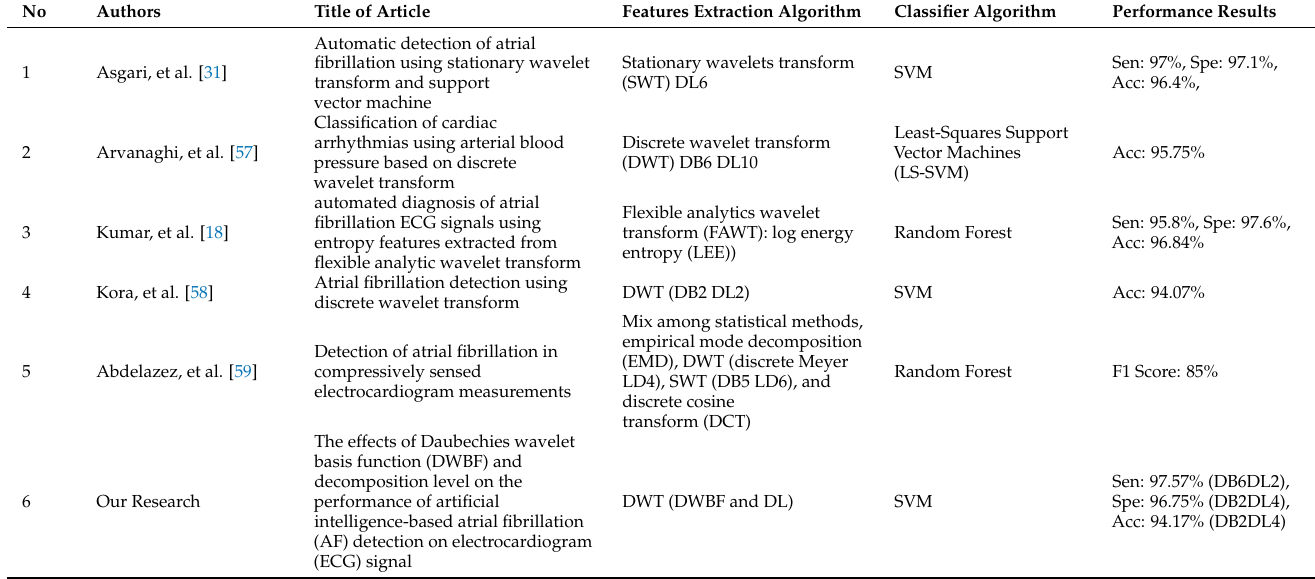
Table 8. Performance of atrial fibrillation detection based on morphological feature extraction algorithm of ECG signal using machine